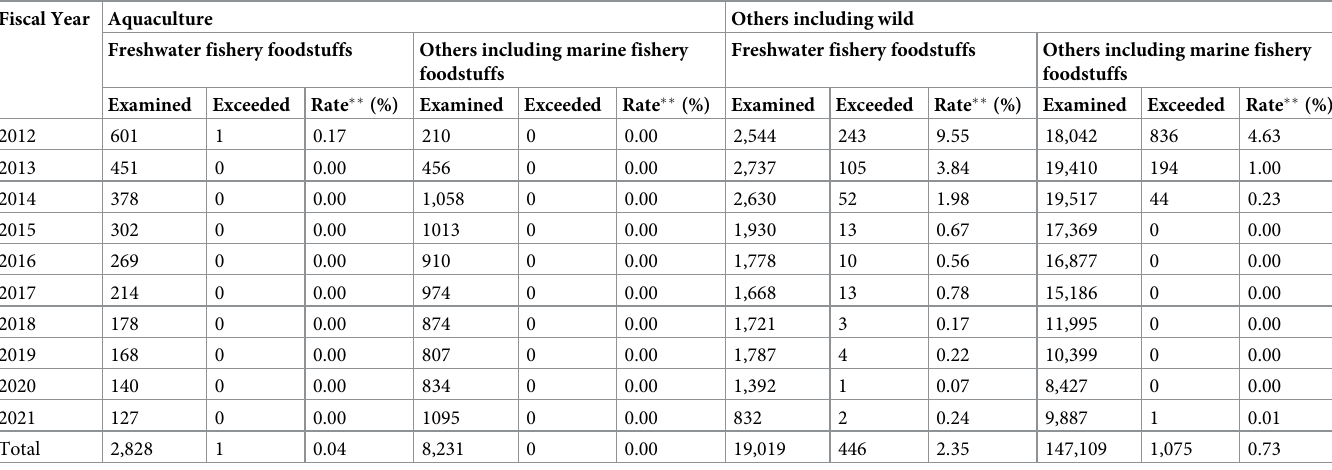
Table 2. Origin of the examined fishery food products that were reported to exceed 100 Bq/kg � .